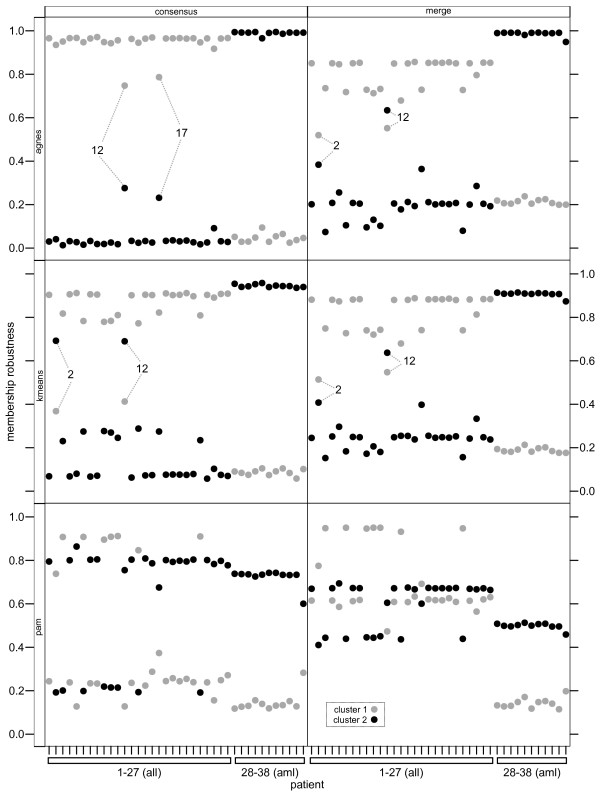
Patient class discovery using a consensus clustering approach. The leukaemia gene expression data set of Golub et al. [22] was used to assess the utility of consensus clustering to the segregation of patients into either an all (1-27) or aml (28-38) cluster. Consensus clustering was carried out with 500 iterations and the clustering algorithms agnes, k-means and pam and the membership robustness was calculated and plotted against patient number for both clusters. All three algorithms correctly segregated the aml patients into the same cluster ('consensus' panels, cluster 2, black filled circles), but only agnes (all) and k-means (all but 2 and 12) segregated the all patients reliably, whereas pam failed to correctly segregate 8/27 all patients. Merge consensus matrices were generated and membership robustness calculated for each of the three clustering structures ('merge' panels). Agnes and k-means produced almost identical results correctly segregating all patients apart from aml patients 2 and 12. Pam correctly segregated all aml patients, but could not segregate 19/27 all patients.